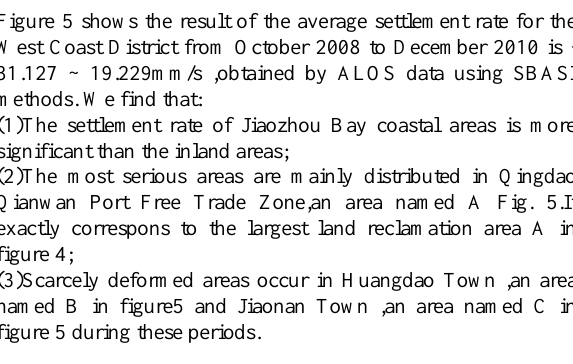
Figure 4. Jiaozhou Bay Coastal Zone’s evolution chart using image extraction from LANDSAT satellite